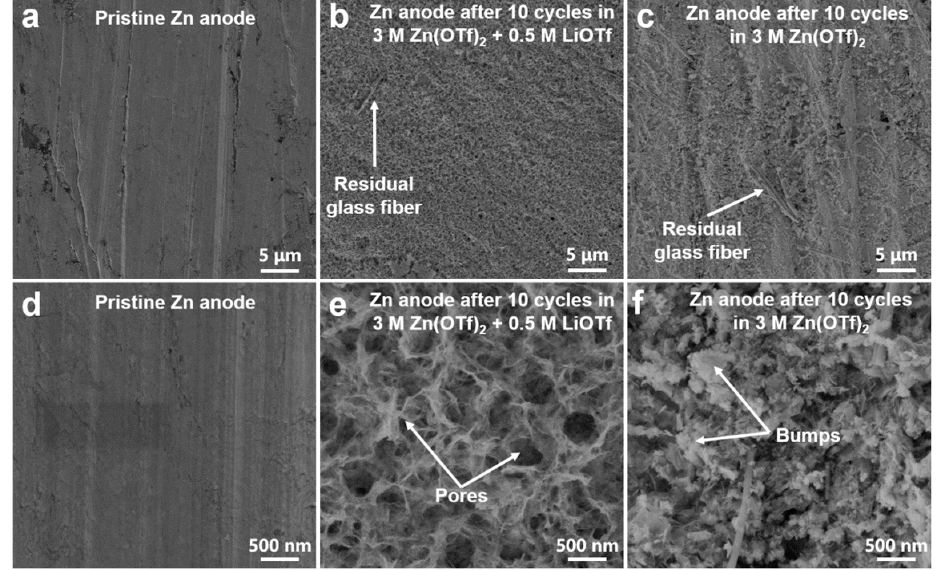
Figure 7. SEM images of ( a , d ) the fress pristine Zn anode, ( b , e ) the Zn anode after 10 cycles in 3 M Zn(OTf) 2 + 0.5 M LiOTf, and ( c , f ) the Zn anode after 10 cycles in 3 M Zn(OTf) 2 + 0.5 M LiOTf. and ( c , f ) the Zn anode after 10 cycles in 3 M Zn(OTf) 2 + 0.5 M